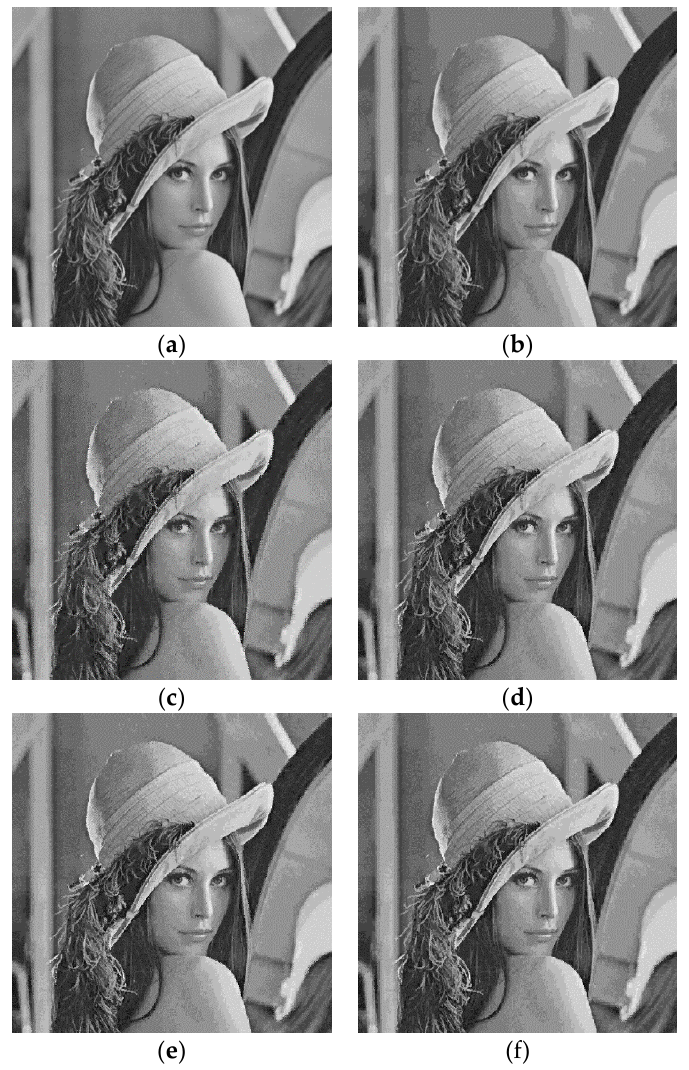
Figure 14. Visual investigation on Image Set 2 with quality factor 𝑄 = 5 : ( a ) input image; ( b ) JPEG decoded image; ( c ) ODBTC; ( d ) EDBTC; ( e ) DDBTC; and ( f ) DDBTC Gaussian method.